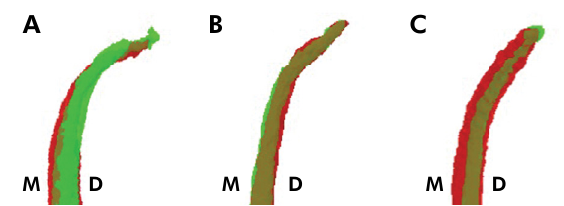
Figure 2. Mesiodistal view (“M” mesial; “D” distal) of three-dimensional reconstruction of the mesiobuccal root canals from mandibular first molars representative of the Wizard Navigator group (A), WaveOne group (B), and ProTaper group (C). Green indicates preoperative area; red indicates postoperative area. Major dentin wear towards the mesial canal wall in “a” (Wizard Navigator group) and in “c” (ProTaper group) and towards the furcal region in “b” (WaveOne group).